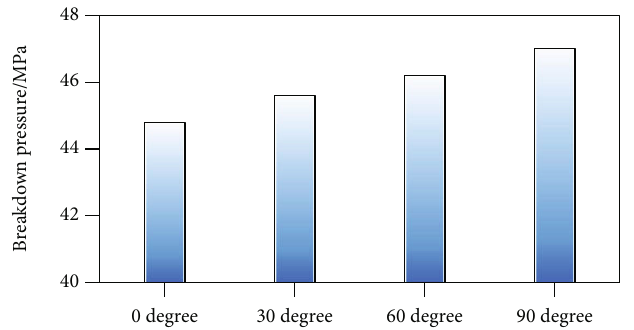
Figure 24: Breakdown pressure having natural fractures and bedding plane with di ff erent angles.